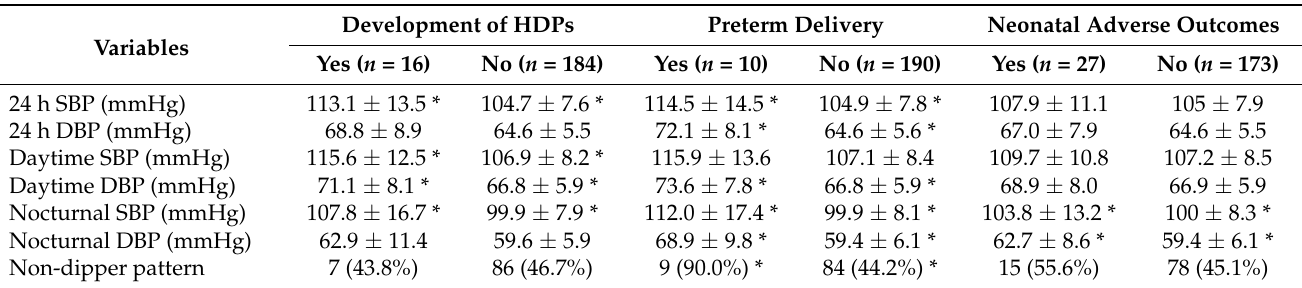
Table 3. Bivariate analysis of the association between BP parameters, analyzed by ABPM, and develop of HDP, preterm delivery and the presence neonatal composite adverse outcomes.